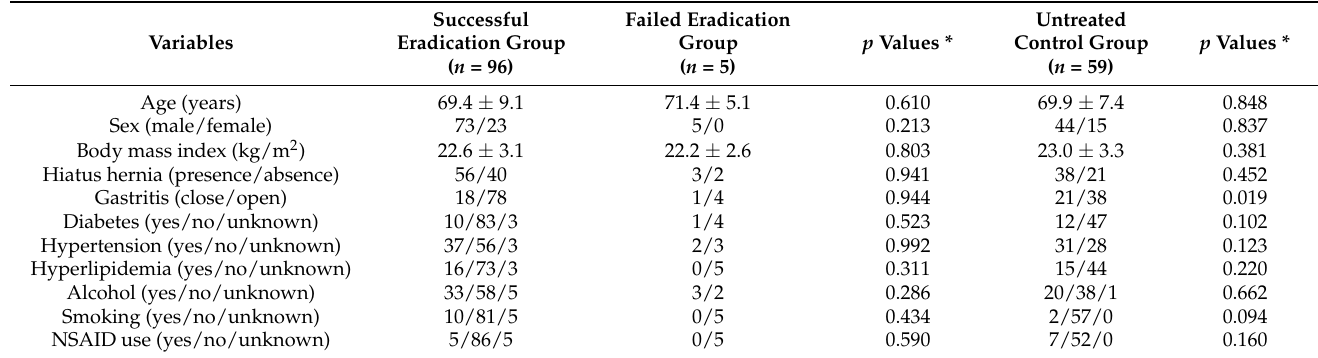
Table 2. Patients’ characteristics.